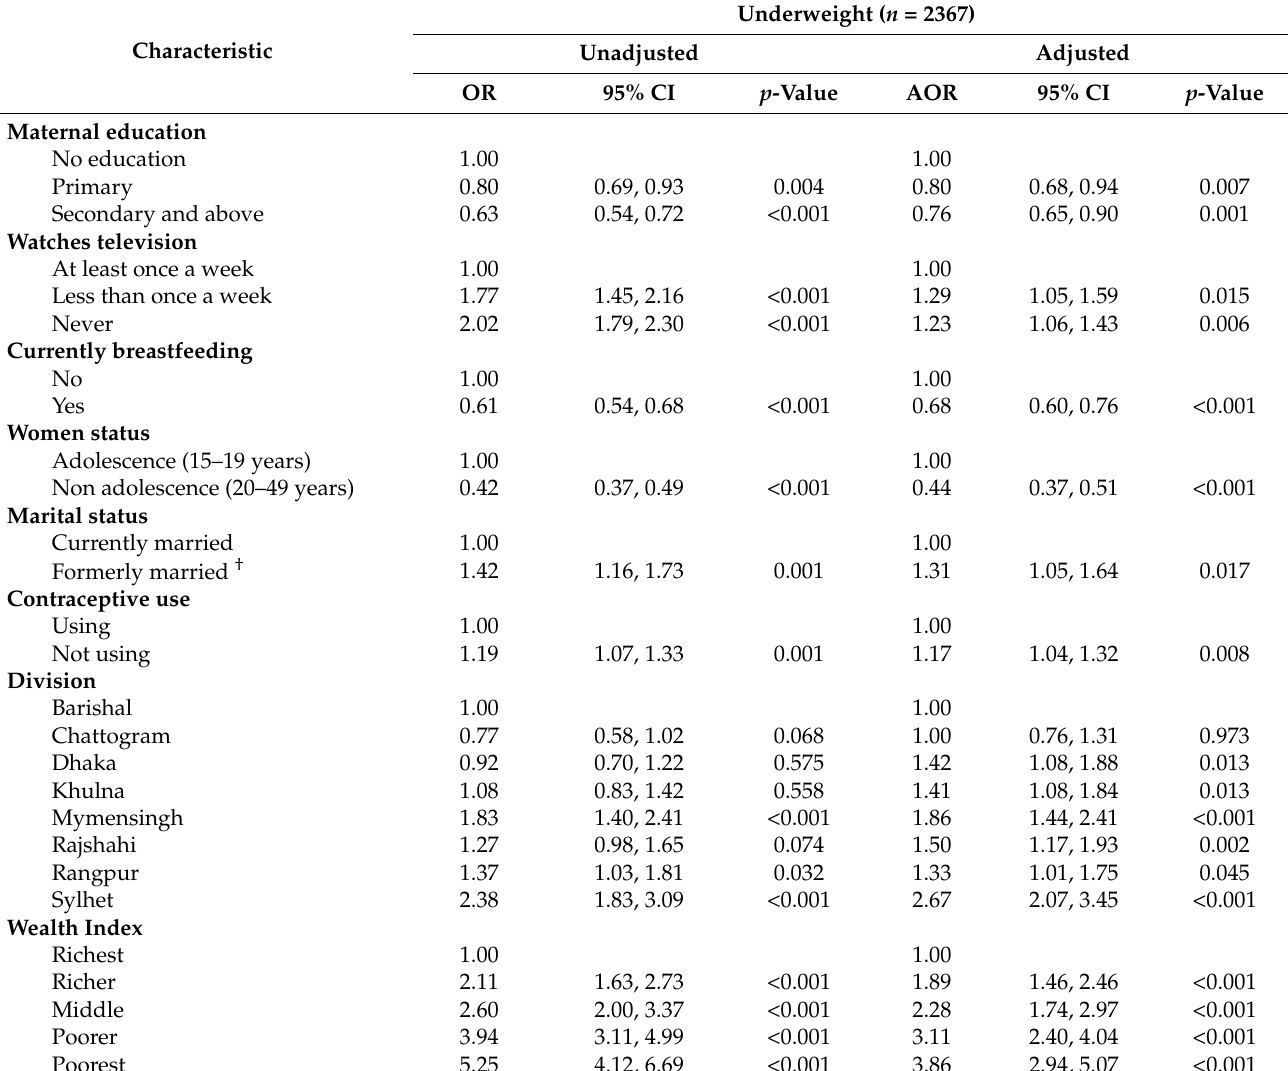
Table 2. Survey logistic modeling of reproductive-age women being underweight: unadjusted (OR) and adjusted Odds Ratios (aOR), Bangladesh